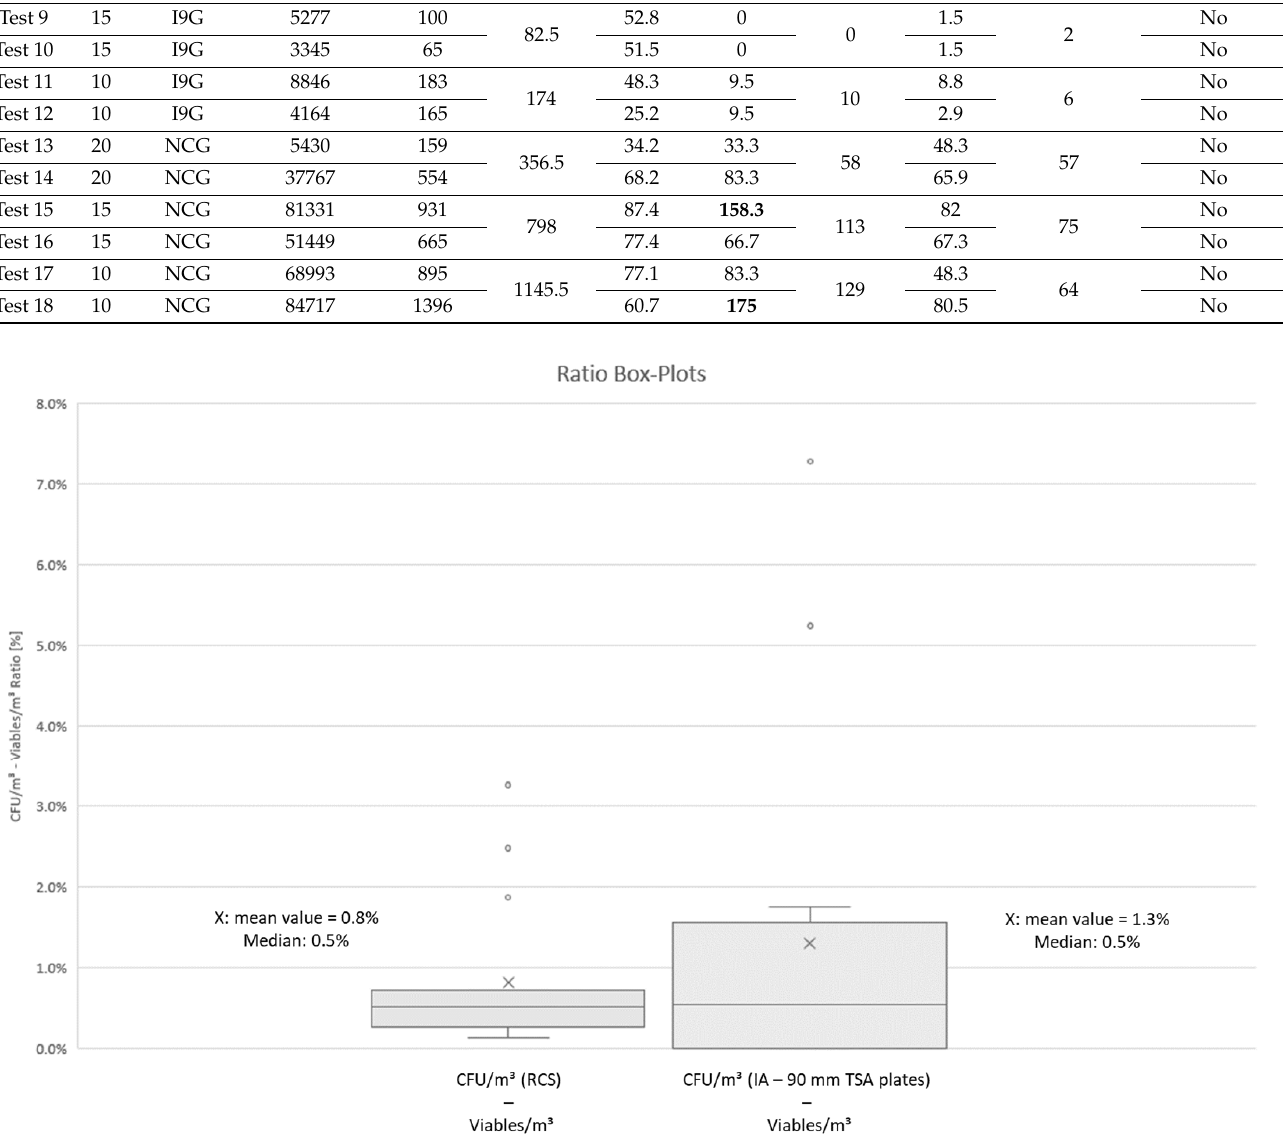
Figure 8. I8G + I9G/ACR 20 + ACR 10 Ratios of CFUs vs. viables.